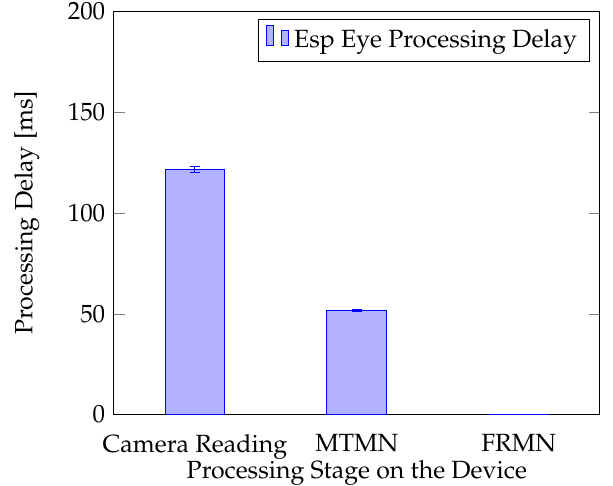
Figure 7. Esp Eye Processing Delay When no Face is Detected in Front of the Camera.